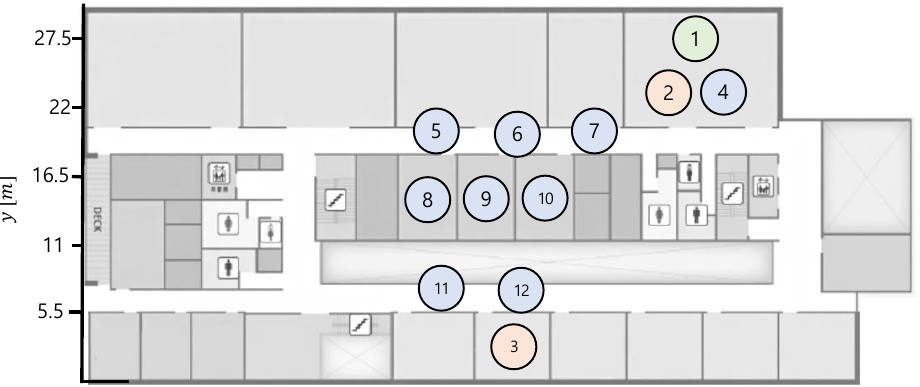
Figure 7. Testbed used in network experiments. Red and blue circles are transmitter nodes and relay nodes, respectively. Green circle denotes a receiver